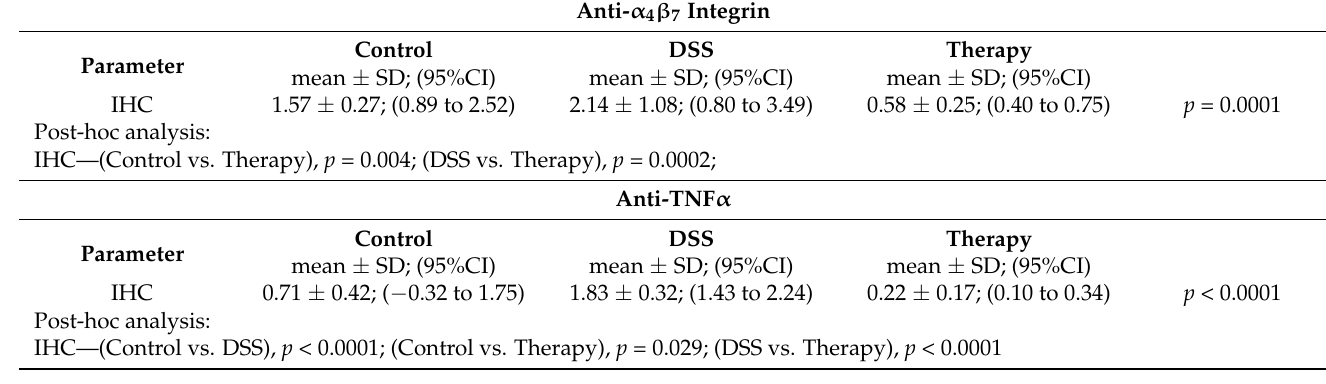
Table 1. IHC scores for radiolabelled mAbs in control, DSS and therapy groups. Anti- α 4 β 7 Integrin